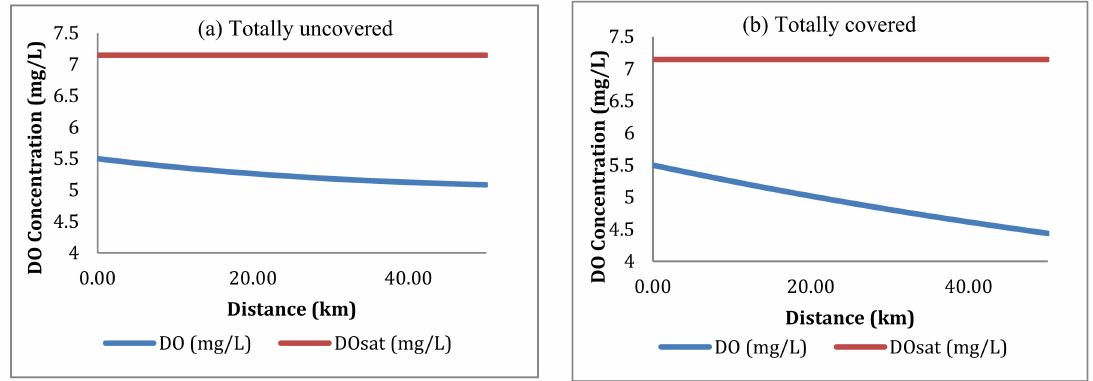
Figure 6. ( a ) and ( b ) The dissolved oxygen (DO) sag curve for the totally uncovered and totally covered cases in the